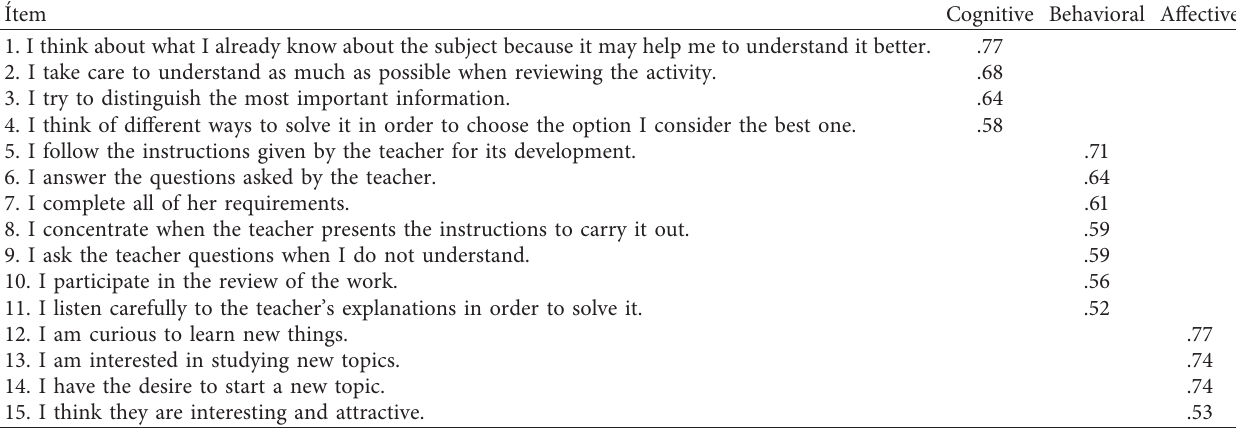
Table 2: Factor weights from exploratory factor analysis for Comp-TA.